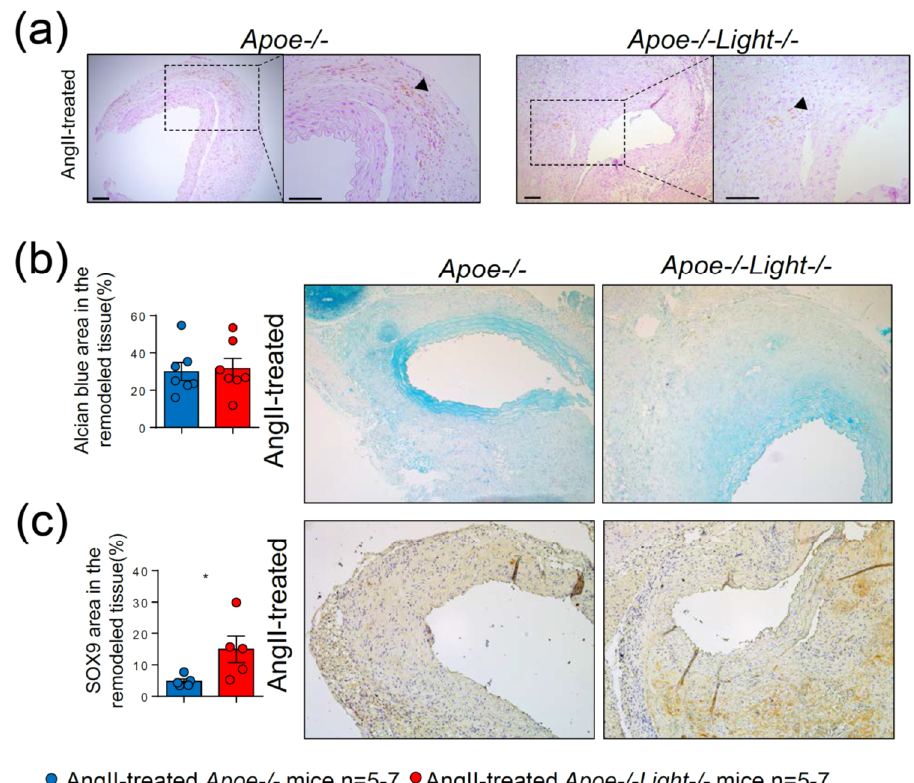
Figure 5. Abdominal aortic cross-section analysis in AngII–treated Apoe −/− and Apoe −/− Light −/− mice. ( a ) Images of vascular calcification determined by Von Kossa staining in aortic aneurysm cross- sections in both groups of mice. ( b ) Mucopolysaccharide quantification in aneurysm determined by Alcian Blue staining area in both mouse groups. ( c ) Sox9 + area in AngII–treated Apoe −/− and Apoe −/− Light −/− mouse aneurysm. Representative images are displayed next to the quantifications. Black triangles point to positive stainings. Scale: 100 µm. Data are mean ± SEM. Statistical analysis was performed using Student’s t test. * p < 0.05.